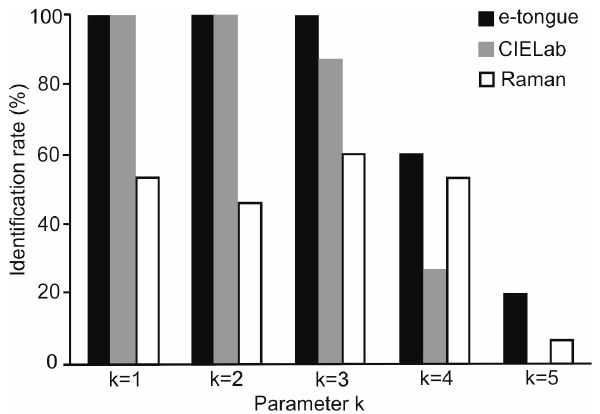
Figure 5. Identification rate of the k-Nearest Neighbors algorithm with different k values.